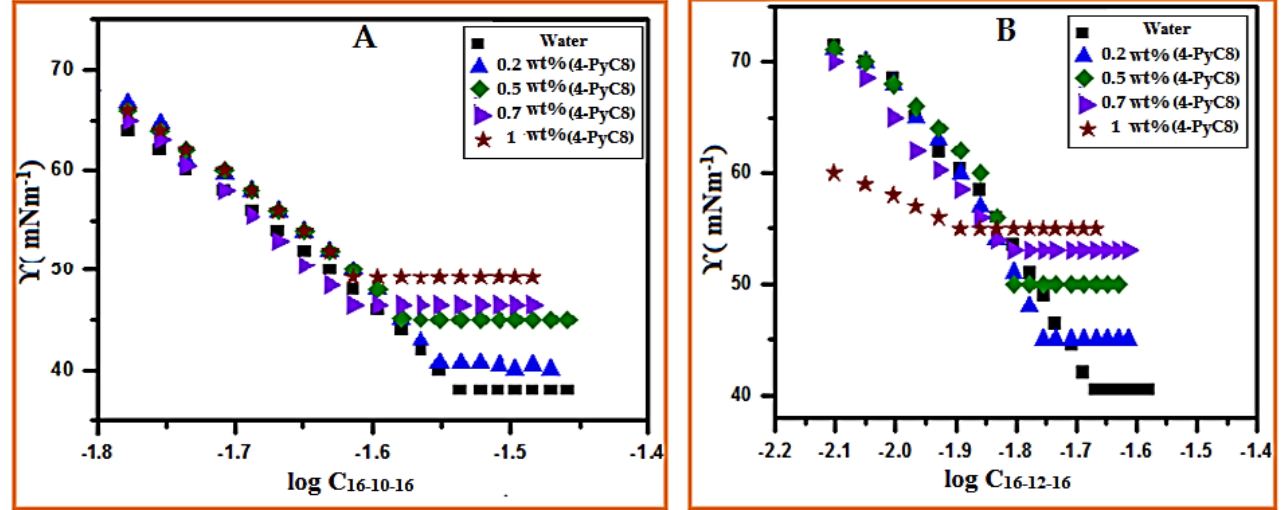
Figure 2. Surface tension vs. logarithm of the concentration of the gemini surfactants 16-10-16 ( A ) and 16-12-16 ( B ) in the presence of various mass fractions (0.2, 0.5, 0.7 and 1 wt%) of the IL 4-PyC8 at 300